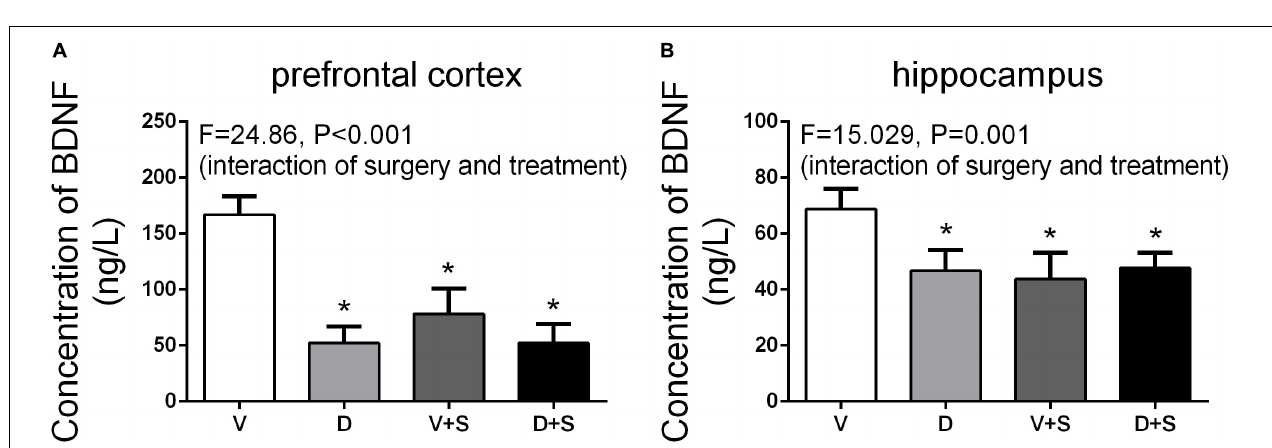
FIGURE 9 | DSP-4 treatment decreased the activation of astrocytes in surgical rats. The activation of astrocytes in the prefrontal cortex (A) and hippocampus (B) at 1 week postoperatively. (C,D) Mean fluorescence intensity in the prefrontal cortex and hippocampus at 1 week postoperatively. The data are presented as the means ± SEM for each group ( n = 3 per cohort). * p < 0.05 compared to Group V, # p < 0.05 compared to Group V + S, DP < 0.05 compared to Group D.